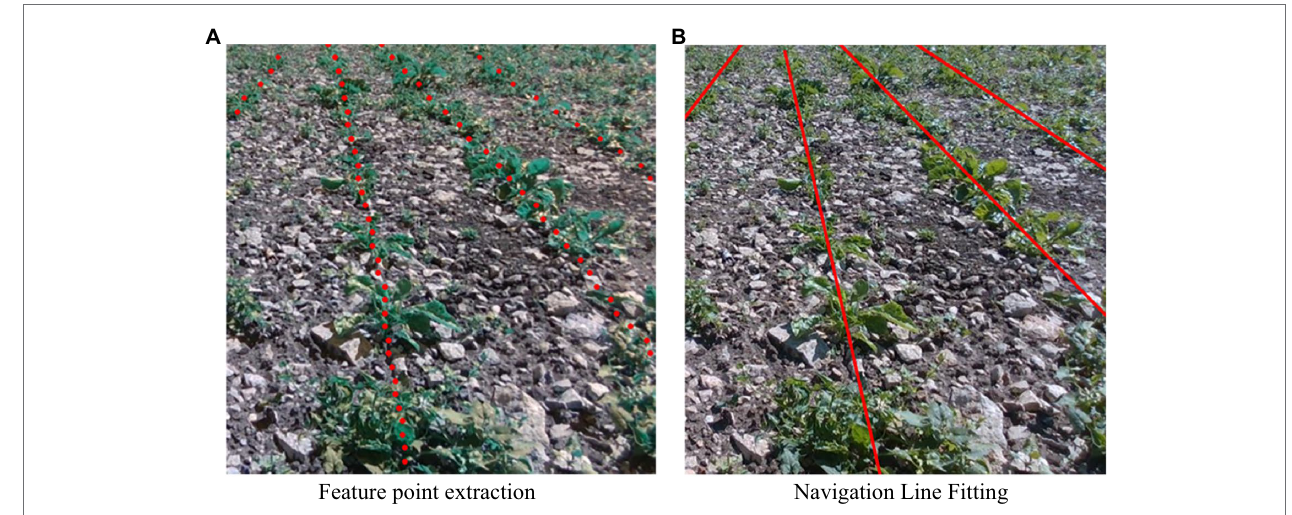
FIGURE 10 | Guideline fitting effect. (A) An example of the result of feature point extraction, where the red dots represent the extracted feature points. (B) An example of the results of the guideline fit. The red line in the figure is an extremely fitted visual navigation line.